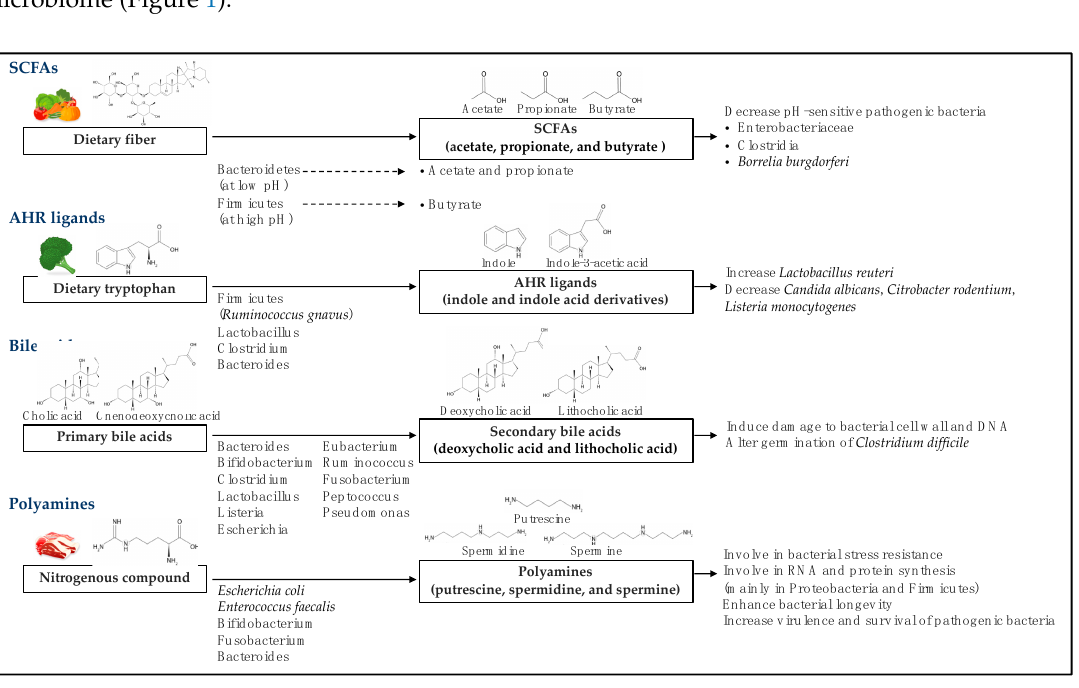
Figure 1. Conversion of dietary components and host-derived molecules to metabolites and their effect on microbial clades. Abbreviations: SCFAs, short-chain fatty acids; AHR, aryl hydrocarbon receptor.